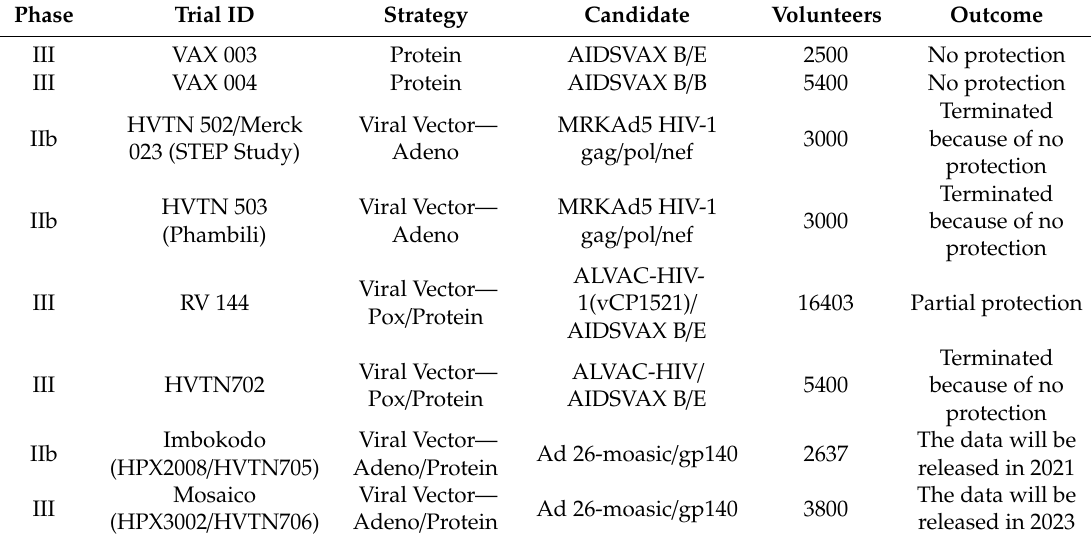
Table 1. Landmark of clinical trials for the HIV vaccines 1